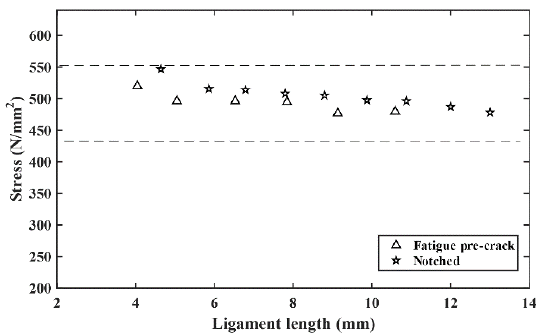
Figure 5. Maximum stress versus ligament length for all DENT specimens.